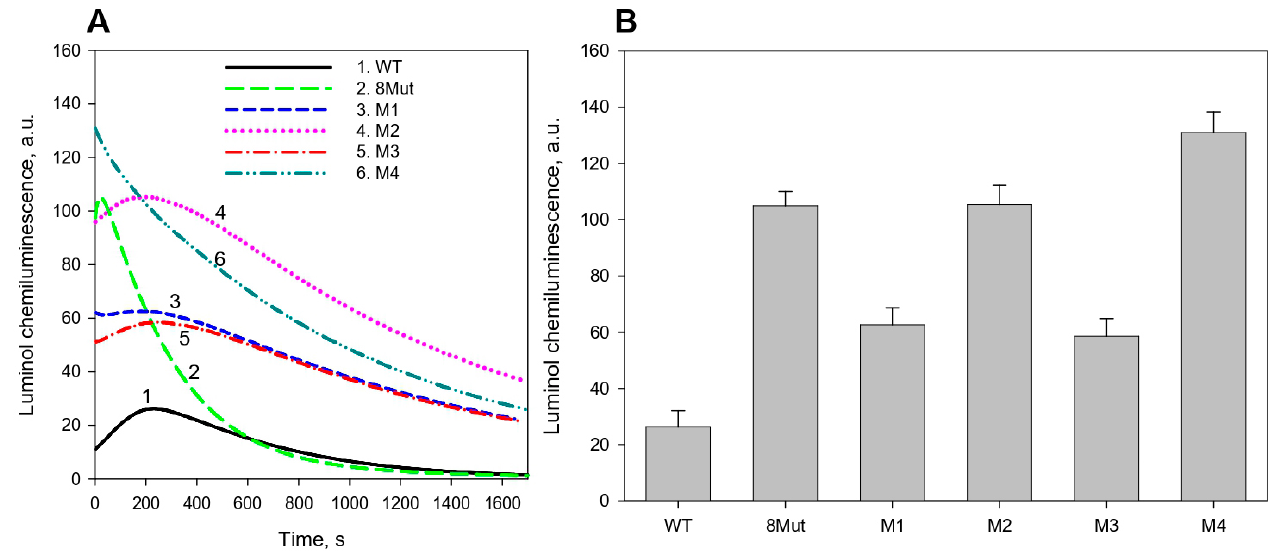
Figure 3. ( A ) Time courses of the intensity of luminol chemiluminescence induced by CytC/H 2 O 2 in the presence of CL-containing liposomes and ( B ) maximum values of luminol chemiluminescence after the addition of H 2 O 2 and CytC mutant forms (8Mut- K8E/K27E/K72E/K86E/K87E/E62K/E69K/E90K, M1-T78N/K79Y/M80I/I81M/F82N, M2-T78S/K79P, M3-I81Y/A83Y/G84N, M4-P76I/G77L/I81L/F82L). Results are expressed as mean ± SE of at least three experiments